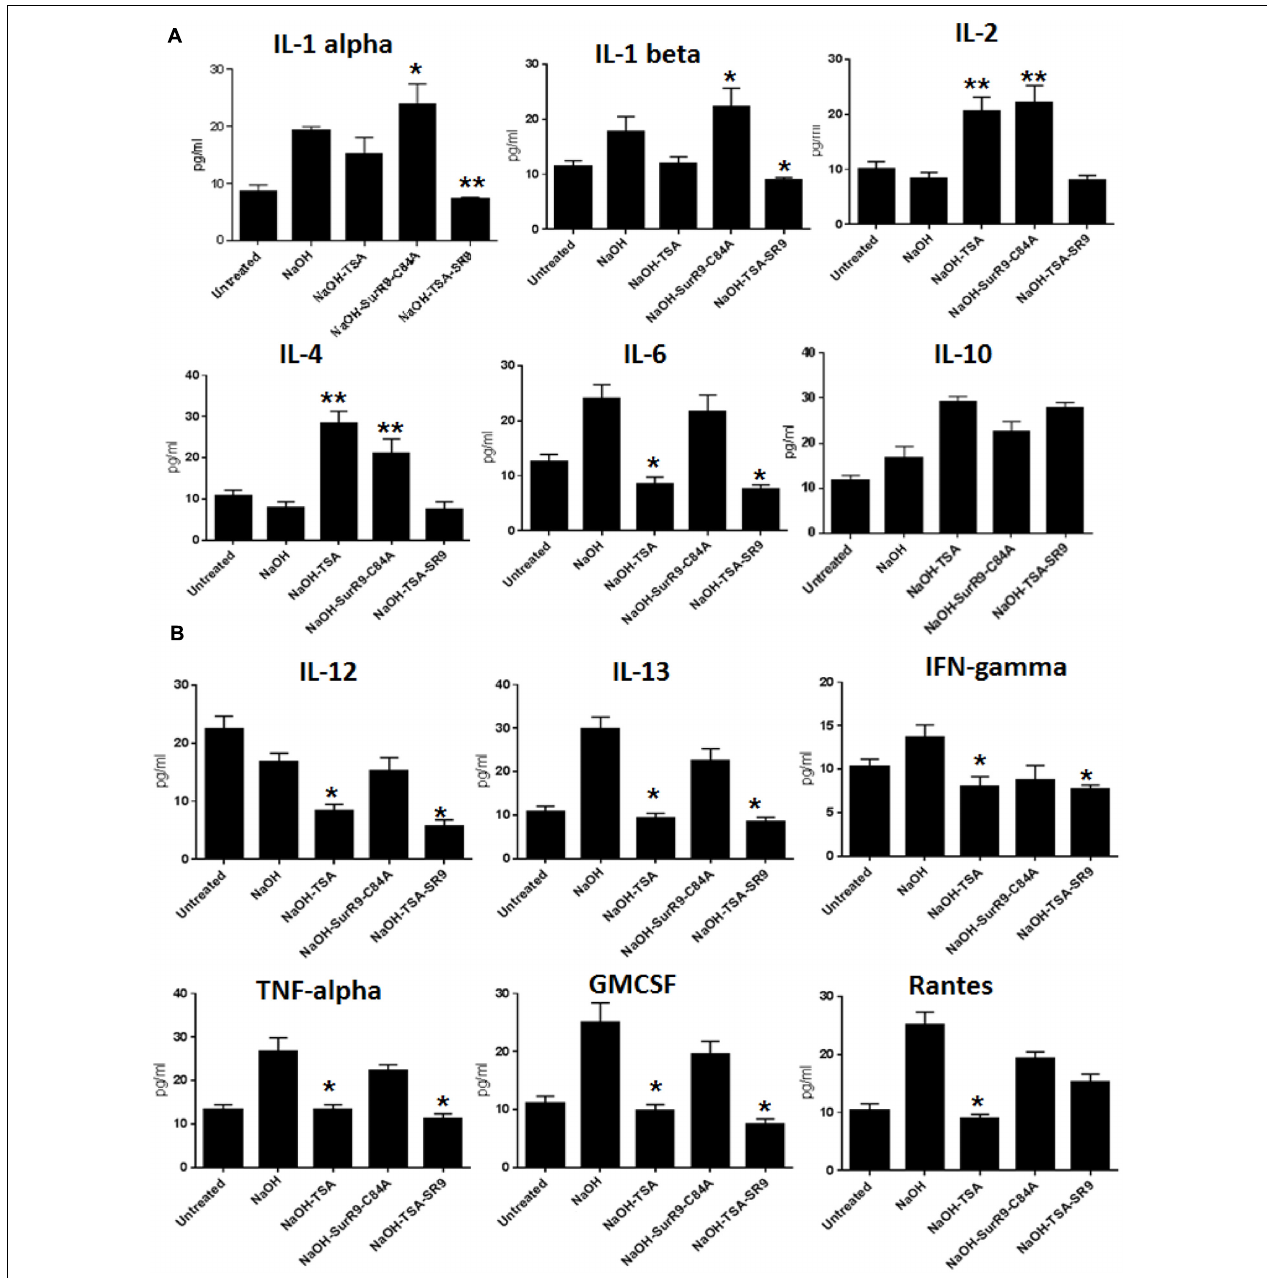
FIGURE 4 | ELISA for expression of pro-inflammatory and anti-inflammatory cytokines: (A,B) The ELISA array was performed to determine the expression of pro-inflammatory cytokines IL-1 alpha, IL-1 beta, IL-2, IL4, IL-6, IL-12, IFN-gamma, TNF-alpha and Rantes and anti-inflammatory cytokines such as IL-10, IL-13, GMCSF. (SR9=SurR9-C84A). The experiments were conducted in triplicates. ∗ p < 0.05 and ∗∗ p <